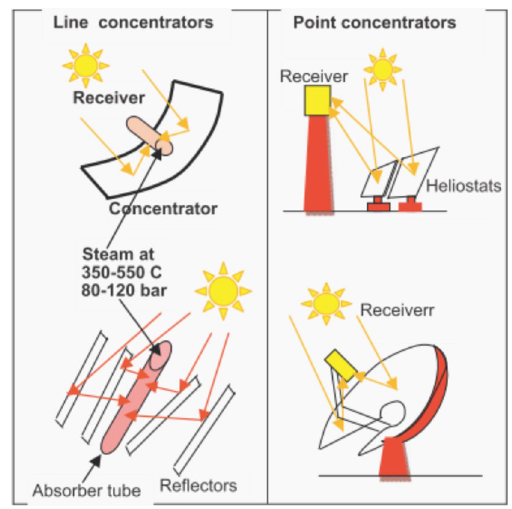
Fig. 30 Various types of solar concentrator methods (Reif and Alhal- abi